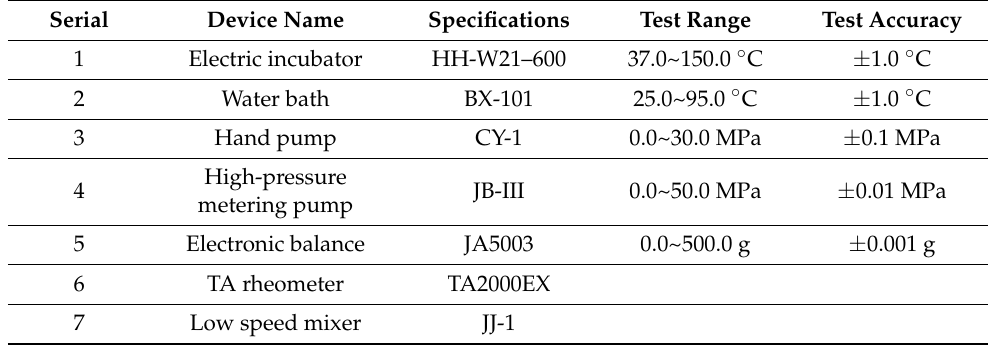
Table 1. Experimental equipment and